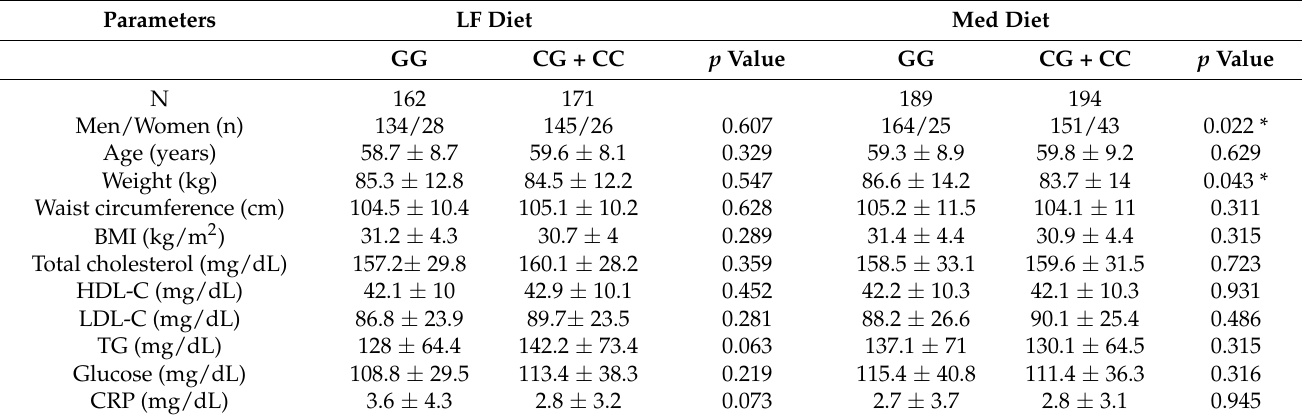
Table 1. Characteristics of patients according to genotype for SIRT1 polymorphism rs7069102 and